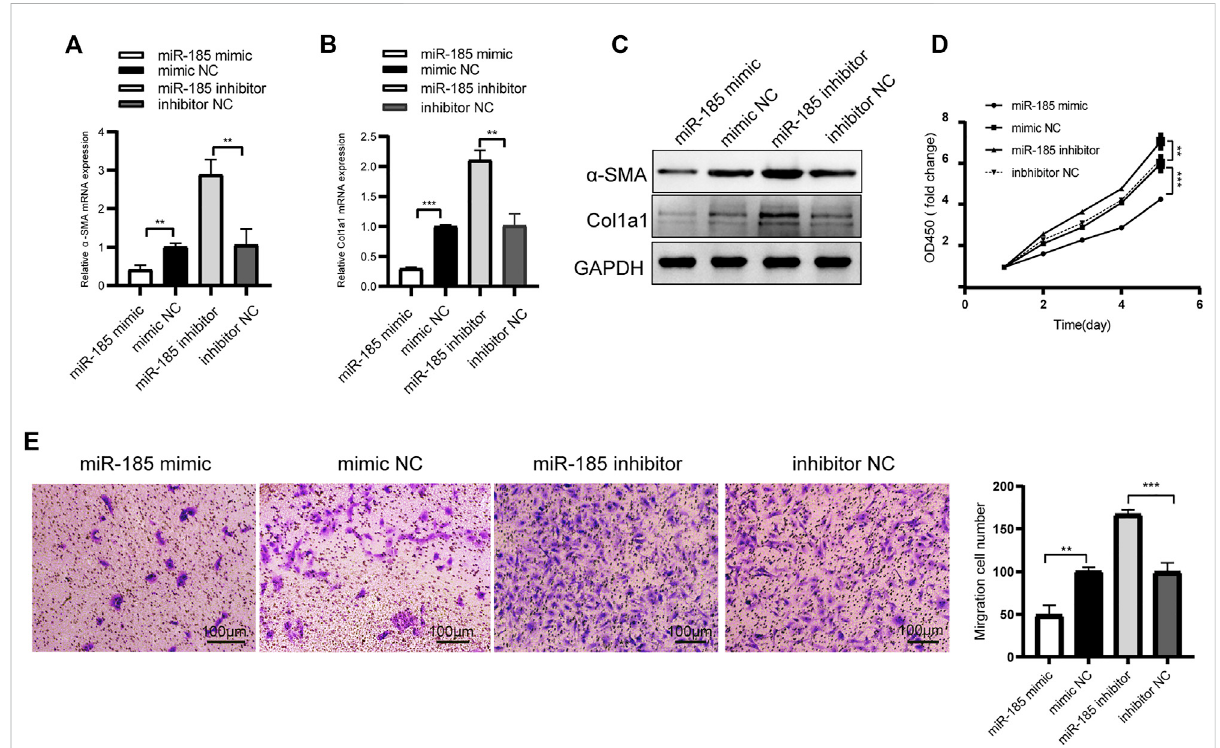
FIGURE 5 miR-185-3p inhibits HSCs activation, proliferation and migration (A and B) The mRNA expressions of α -SMA and Col1a1 were detected by qRT- PCR assay after miR-185-3p inhibitor/mimic transfection (C) Western blotassay showed theprotein expression of α -SMA and Col1a1 after miR-185- 3pmimic ormimic NCtransfection (Dand E) Proliferation and migration ofLX-2 cellsweredetectedby CCK8and transwell assays after miR-185-3p inhibitor/mimic transfection. In CCK8 assay, the OD value at day1 was normalized to 1 and the data are expressed as fold. The RNA levels were normalized to total GAPDH. The protein levels were normalized to total GAPDH. Statistical analysis: Student t -tests. ** and *** stand for p < 0.01 and p < 0.001, respectively. Experiments were repeated independently three